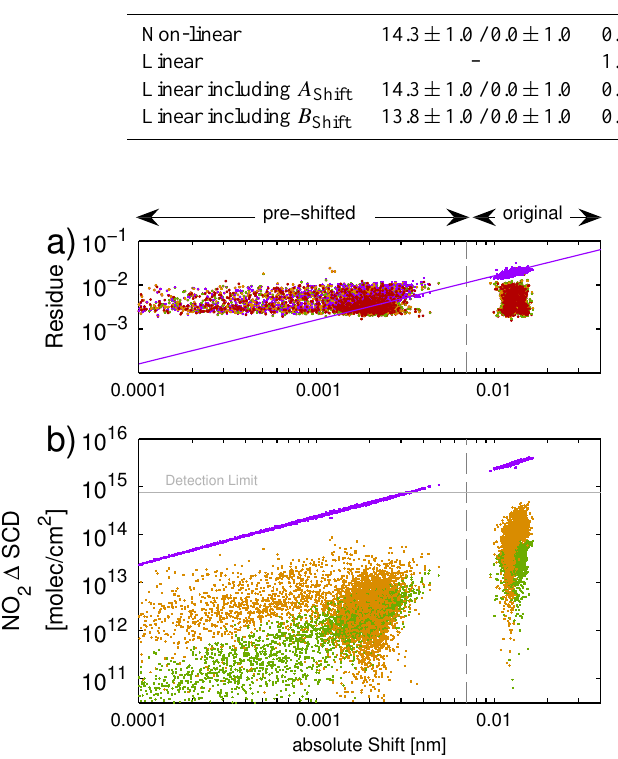
Fig. 7. Dependency of the peak-to-peak fit residues (a) and the ab- solute NO 2 SCD bias with respect to the non-linear fit (b) on the absolute spectral shift (as found by the non-linear fit). Colours as in Fig. 5. The purple line corresponds to Eq. (9) for a = 0 . 4 and ς = 0 . 3nm. Results from the original (shift > 0.007 nm) and the pre-shifted set of references (shift < 0.007 nm) are